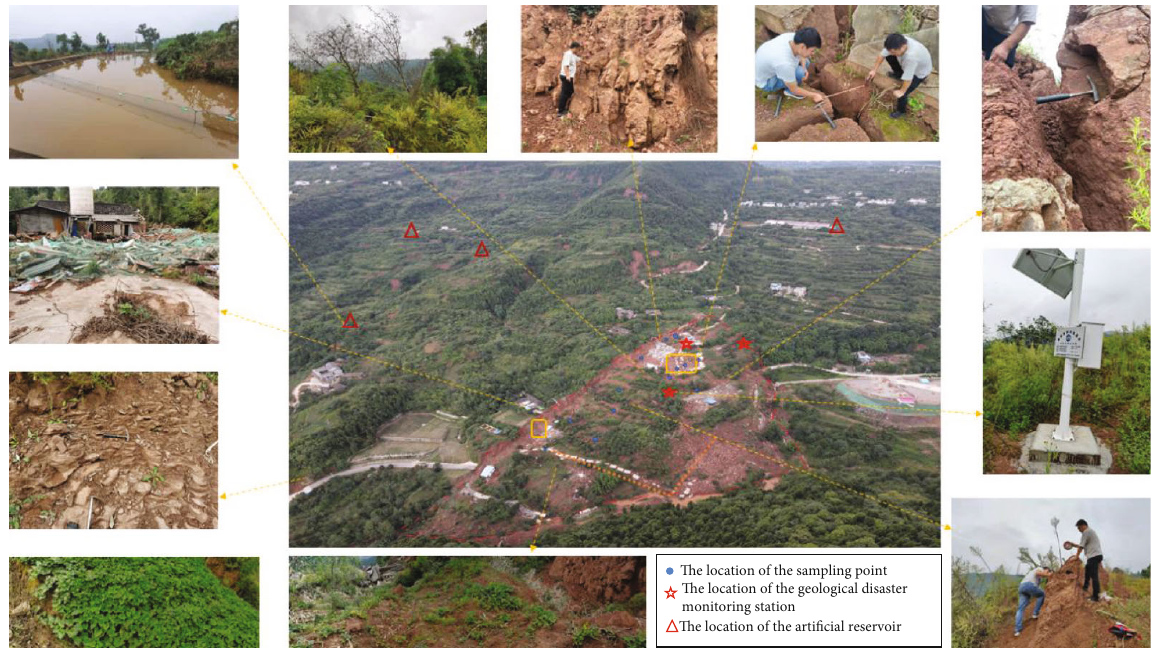
Figure 25: Comprehensive analysis of the landslide. Table 4: Surface fi ssure changes after the occurrence of the